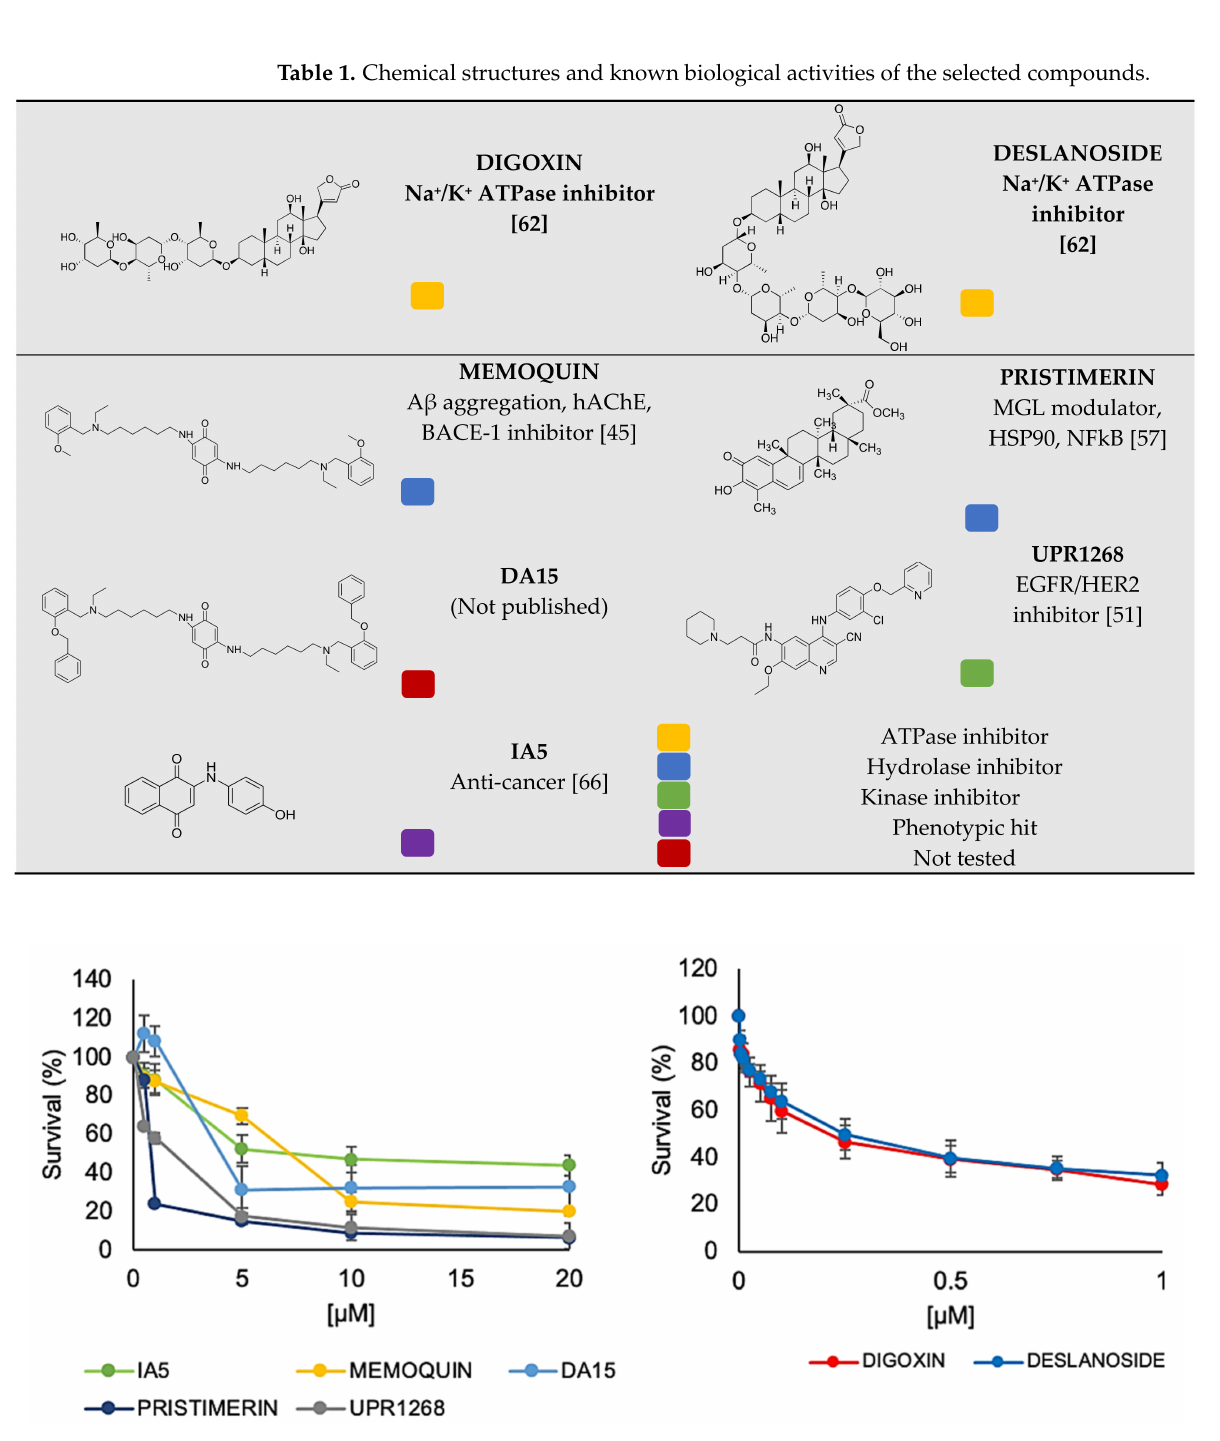
Figure 5. MTT assay of the selected compounds in HaCaT cells after 48 h of treatment. Left: dose dependent inhibition of the most active compounds showing an IC 50 below 10 µ M. Right. compounds showing an IC 50 at nanomolar concentration. Error bars represent s.d. (n =